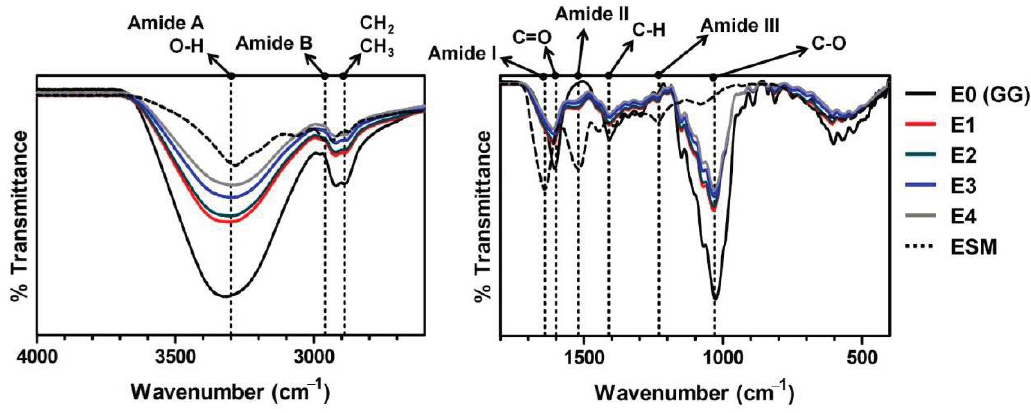
/ GG hydrogels with di ff erent amounts of Figure 3. FT-IR spectra of the ESM/GG hydrogels with different amounts of ESM. Figure 3. FT-IR spectra of the ESM Figure 3. FT-IR spectra of the ESM/GG hydrogels with different amounts of ESM.